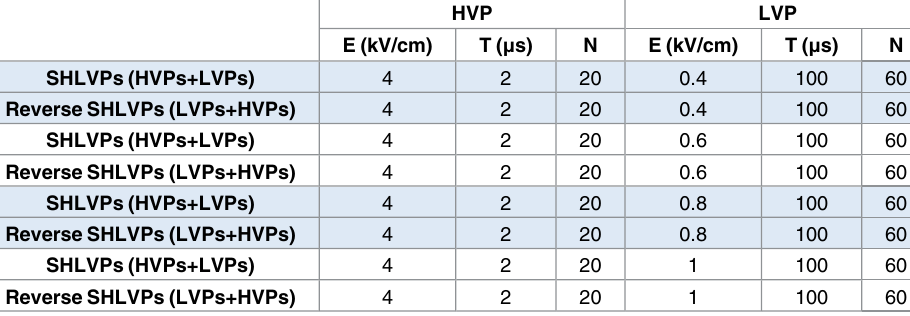
Table 2. Schemes for SHLVPs with different sequences.